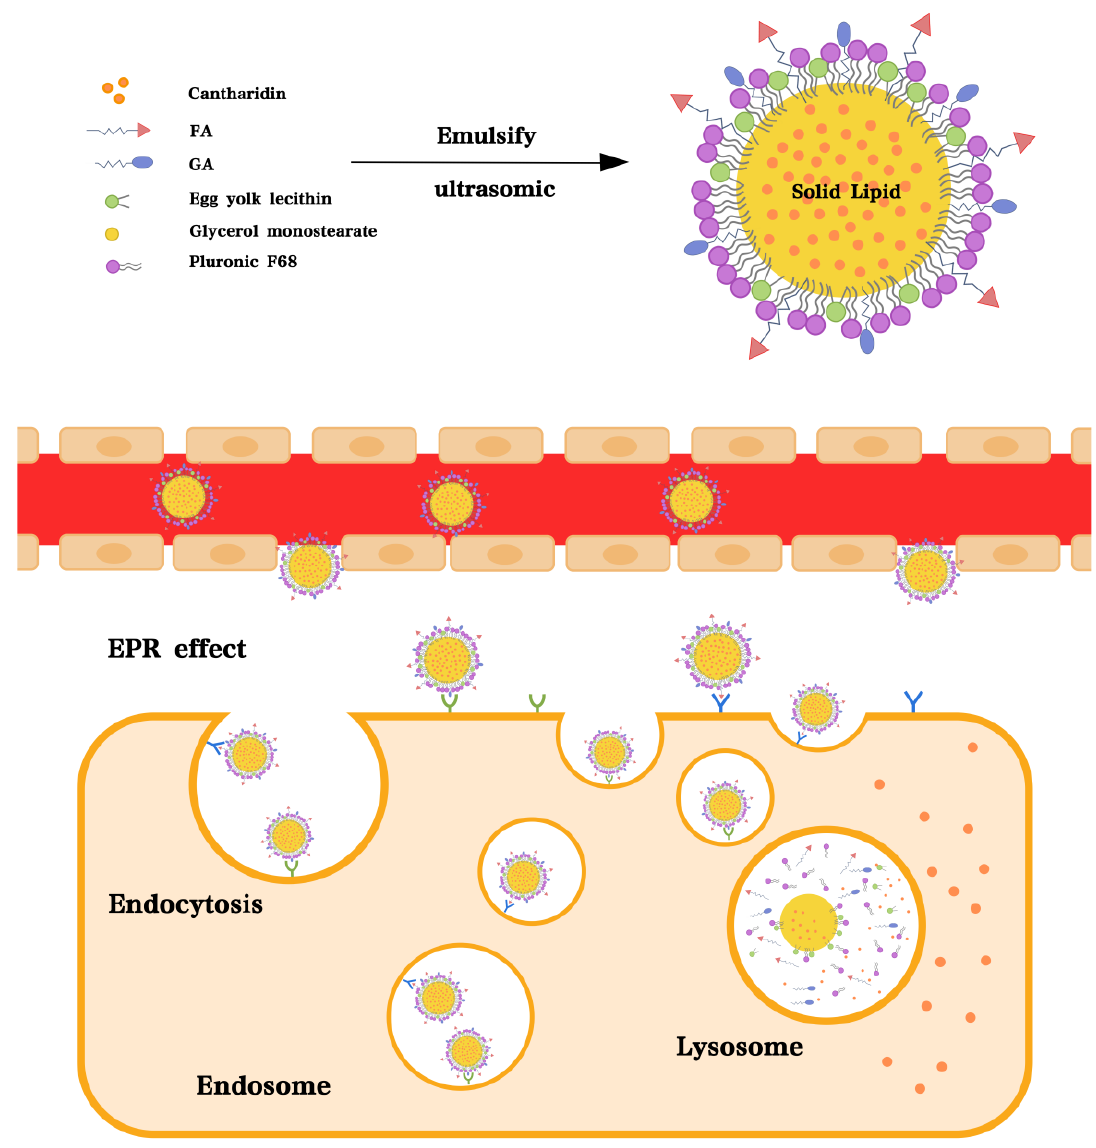
Figure 1. Schematic diagram of GA-FA-CSLNs.